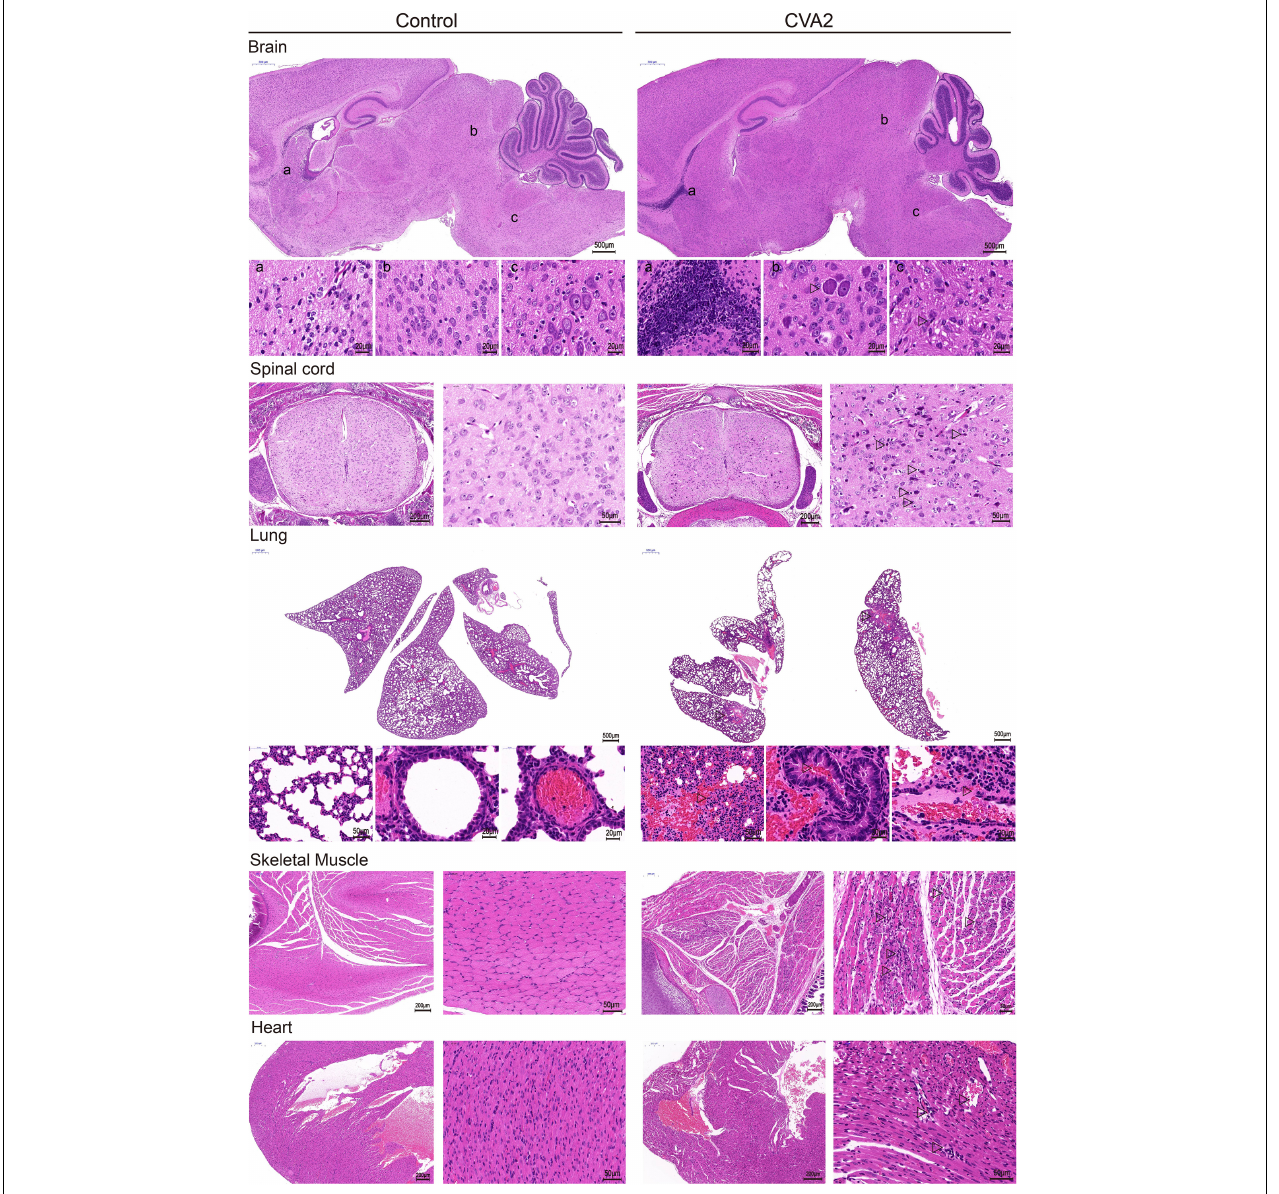
FIGURE 3 | Histopathological changes in CVA2-infected mice. In the brain tissue and spinal cord, neurophagy and lymphocyte infiltration occurred. The lungs presented inflammatory hyperemia characterized with massive erythrocytes leakage. The skeletal muscles exhibited myofiberlysis, necrosis, and inflammatory cell infiltration. Severe viral myocarditis was observed, characterized with lymphocytic and mononuclear cell infiltration and myocardial rupture. In control mice, the upper organs or tissues were almost unaffected. All experiments were repeated for four